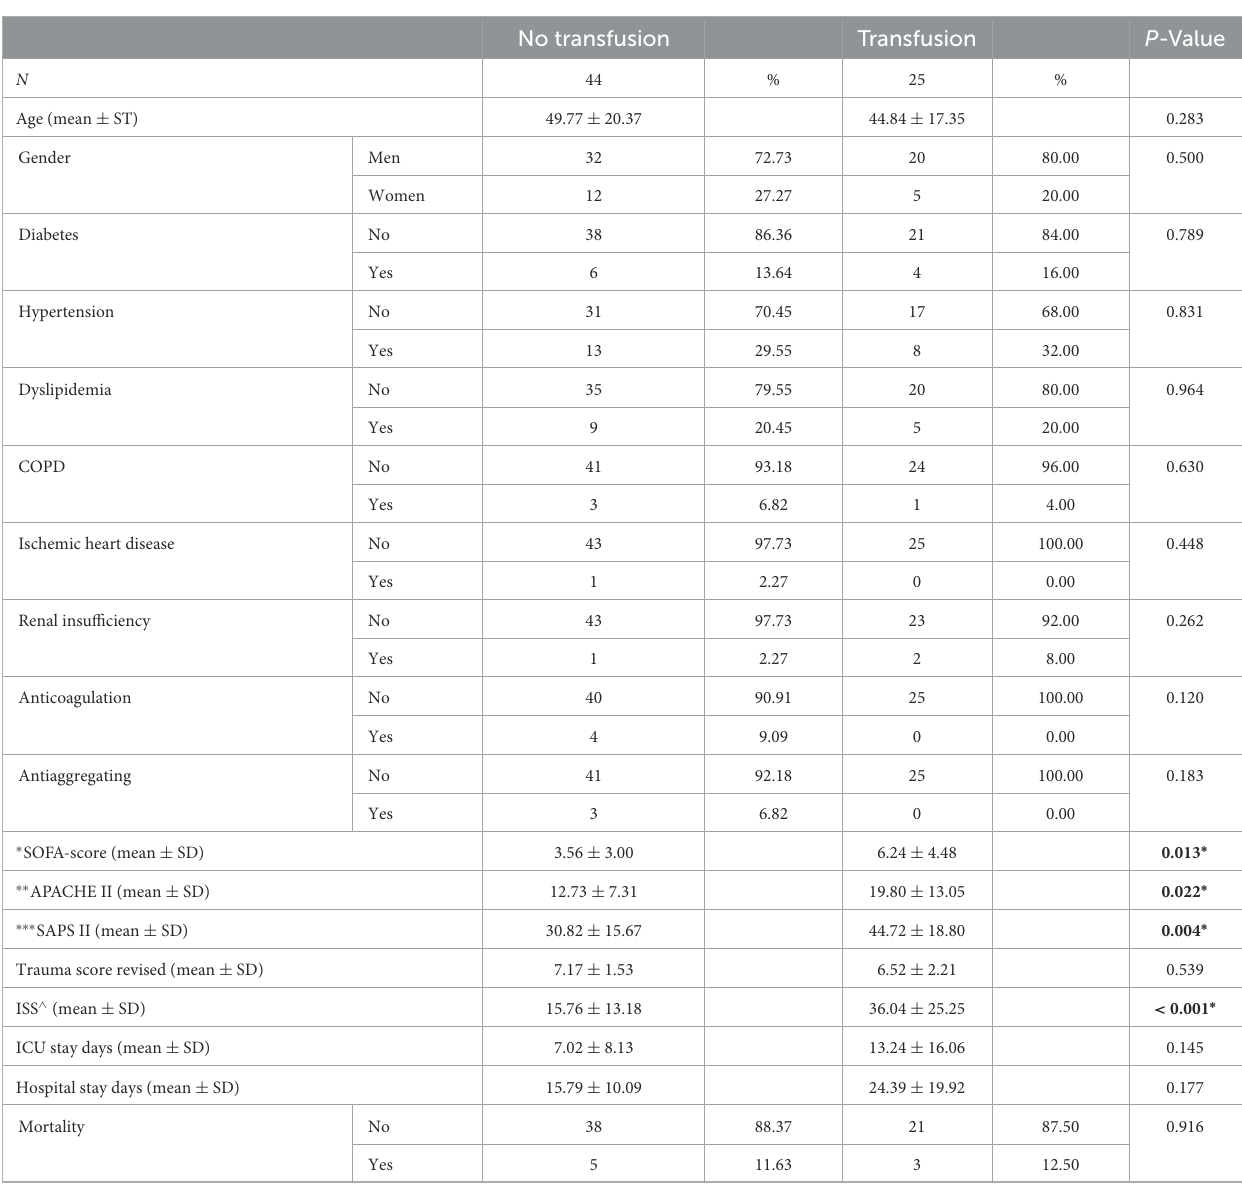
TABLE 1 Demographic